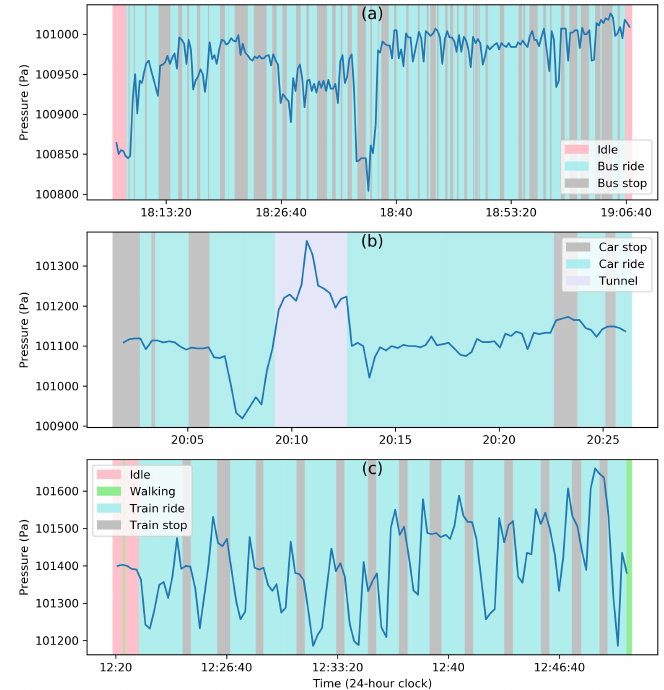
Figure 3. Illustration of the effect of air velocity during motion for a ( a ) bus ride, ( b ) car ride and the effect of the built environment (tunnel), and ( c ) subway train ride. Each panel shows the effect of air velocity during motion on the barometric pressure, with different modes of transport showing different types of changes. Subway train rides yield the highest changes in magnitude ( ∼ 200 Pa), while bus and car rides show relatively smaller amplitude changes ( ∼ 50 Pa), except when a car is entering a tunnel. The panels also show the effect of elevation changes during travel. In panel ( a ), there is a fall and rise in pressure around 18:35, corresponding to a climb and descent on the road path. Similarly, a drop and rise in pressure is observed in panel ( b ), where the car climbed and descended on an elevated bridge just before entering a tunnel. In panel ( c ), the acceleration of the train as it leaves the stop creates a sudden pressure drop, and a rise in pressure is subsequently observed as it approaches a stop, followed by a small dip in pressure as the train comes to equilibrium with the station environment, thus creating a repeating pressure pattern. Data were recorded by carrying a custom-made device (barometer model: BMP280) in different transport modes with a sampling rate of ∼ 0.06